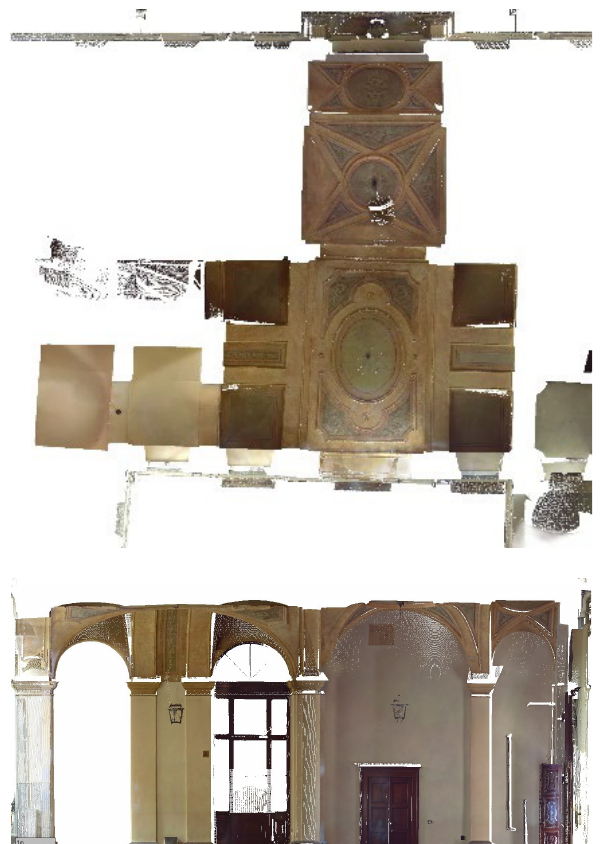
Figure 7 . Horizontal and vertical sections extracted from the point cloud using Clipping box command (processing by C. López